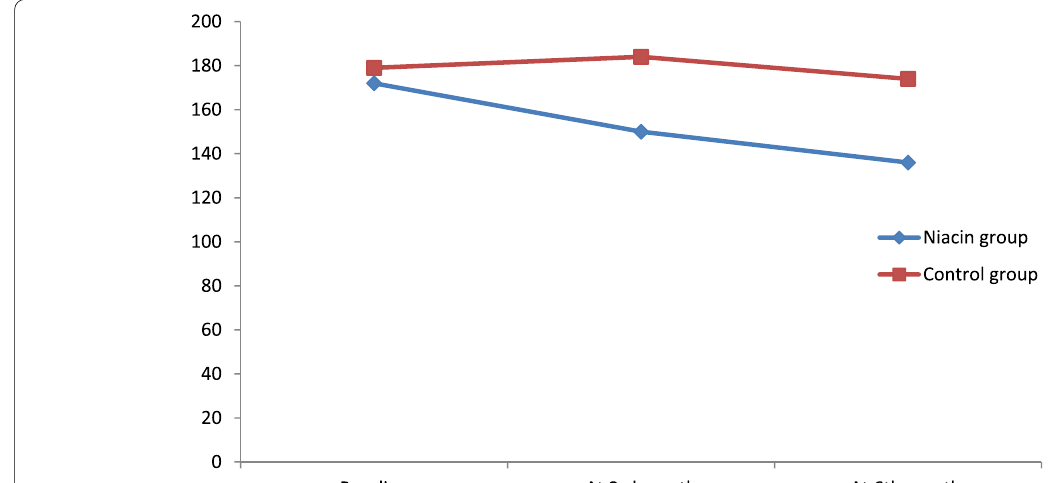
Fig. 6 Changes in level of cholesterol in both groups